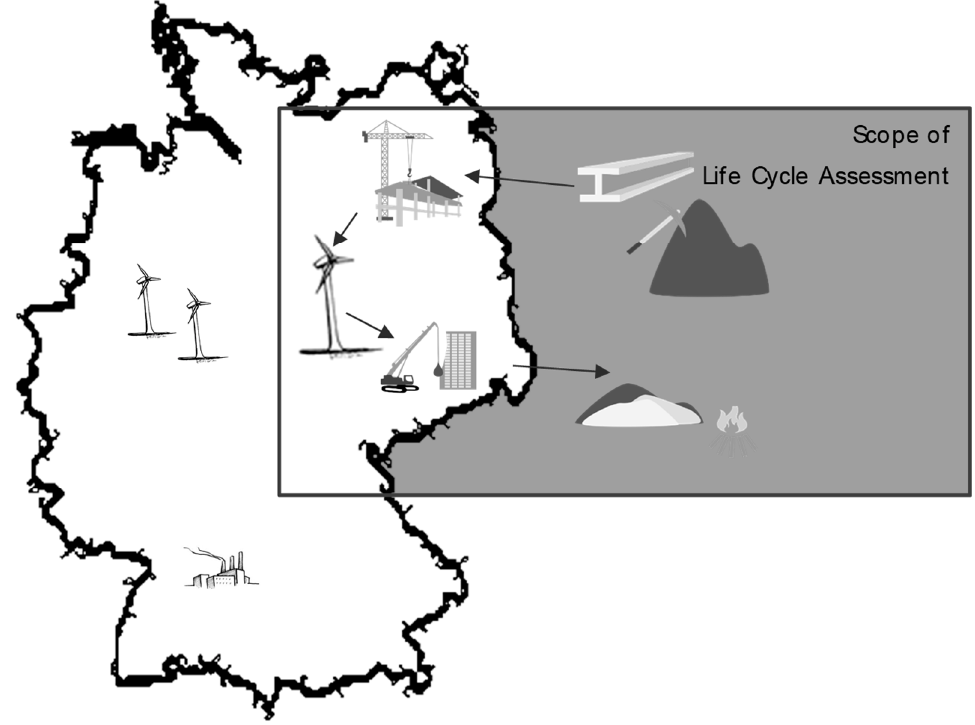
Figure 2. Graphical representation of the necessary adjustment in LCA for an integration into ESA with the geographical scope of Germany. Grey parts of the life cycle are included in the assessment; parts covered by the systems under investigation in the ESA are cut off to avoid double counting as the emissions are already covered by the ESA model.